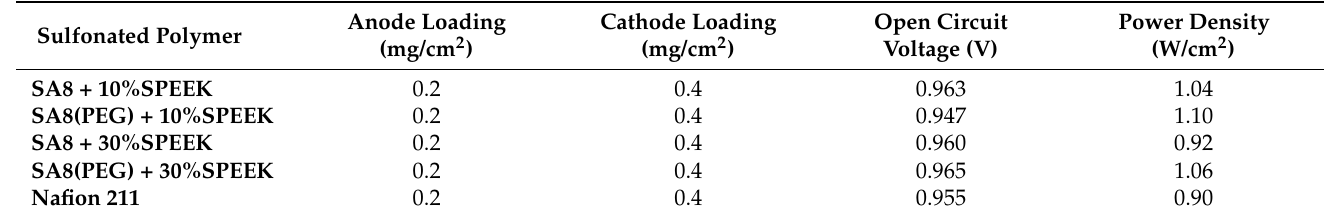
Table 7. Component measurement conditions and performance of SA8 blended with PEG and 10% sPEEK and 30% sPEEK.